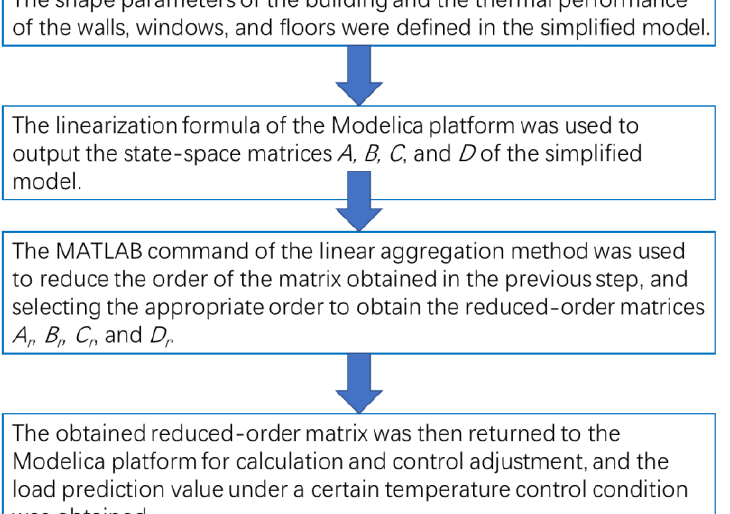
Figure 7. Procedure used to obtain the RM model.